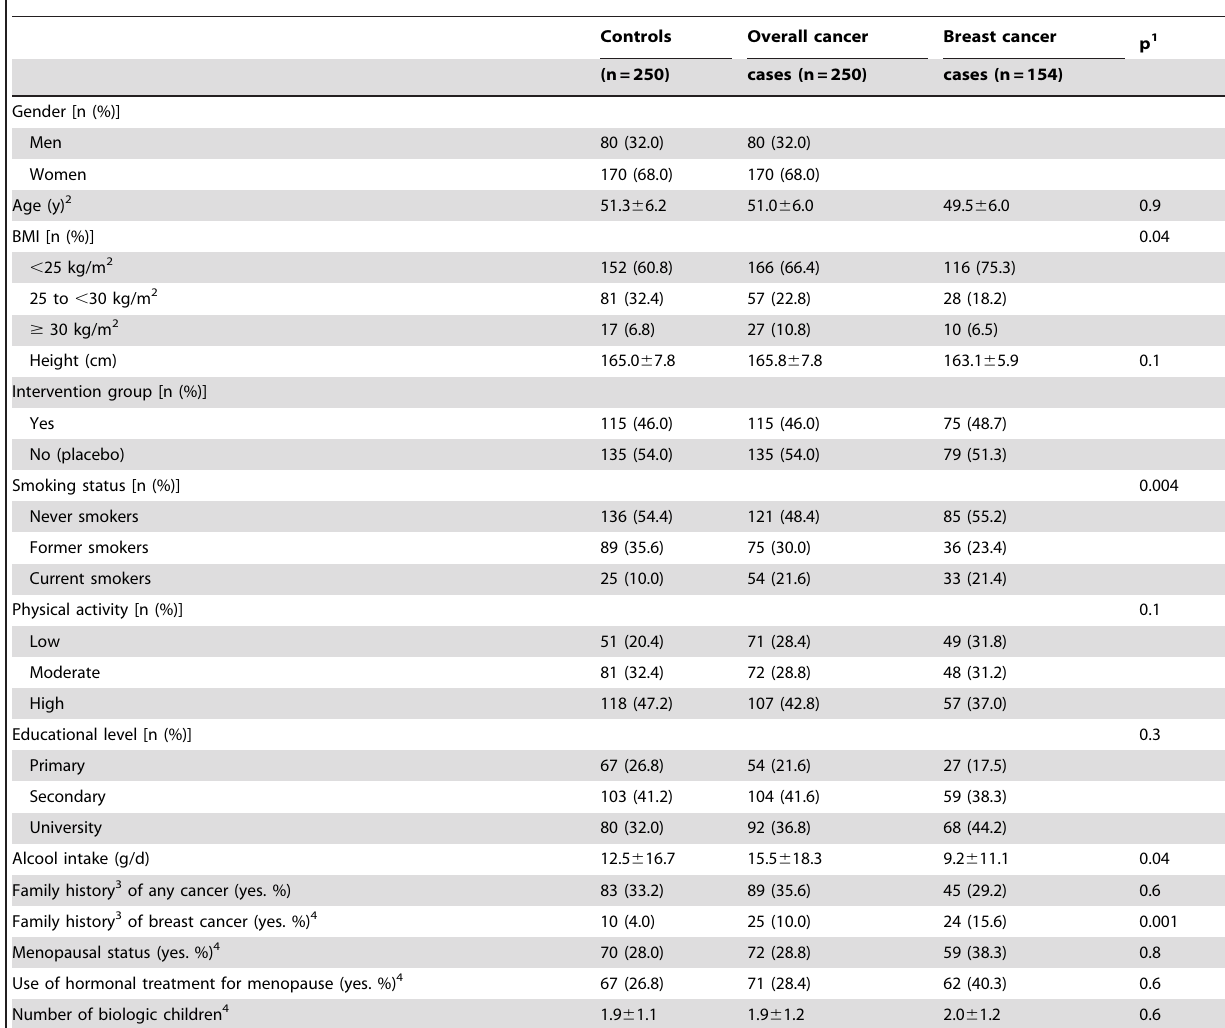
Table 1. Baseline characteristics of cancer cases and matched